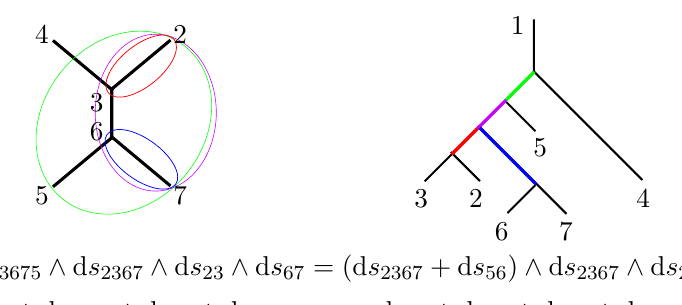
Figure 5. Illustration of non-zero pullback of a cubic tree to H ( C n